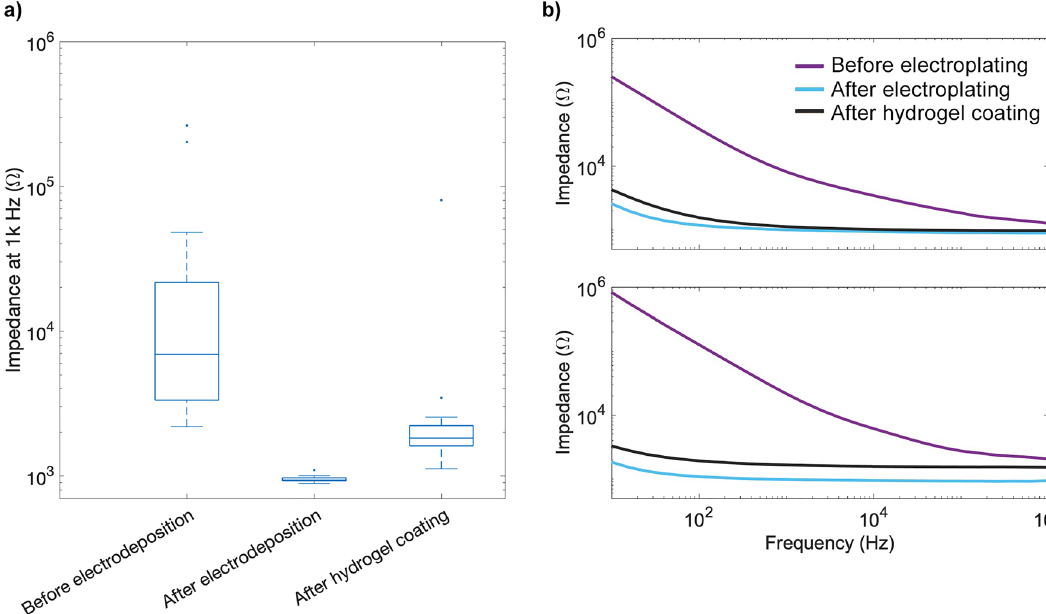
Figure 2. Impedance characterization of electrodes. ( a ) A box-and-whisker plot shows the distribution of impedance of the electrodes at 1 kHz (14 electrodes in total). The box represents the range of data between the first and the third quartile, and the whiskers represents the maximum and minimum data points without outliers (labeled in dots). The solid line inside the box represents the median value. ( b ) Two representative EIS trends of two out of the 14 electrodes.